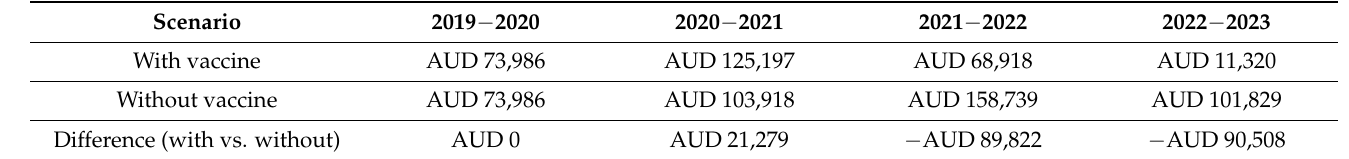
Table A8. Impacts on the Commonwealth Govt budget (Financial year, AUD m changes)—Expenses— with and without vaccine vs. no COVID